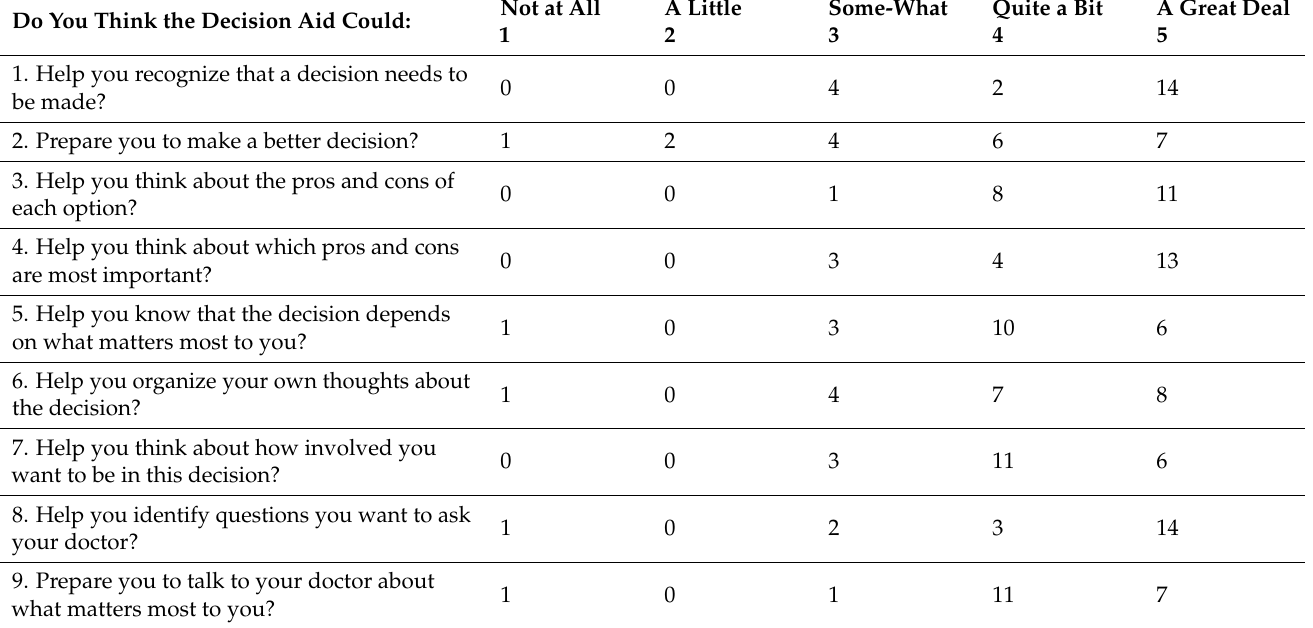
Table 2. Preparation for decision making for patients and family members ( n =